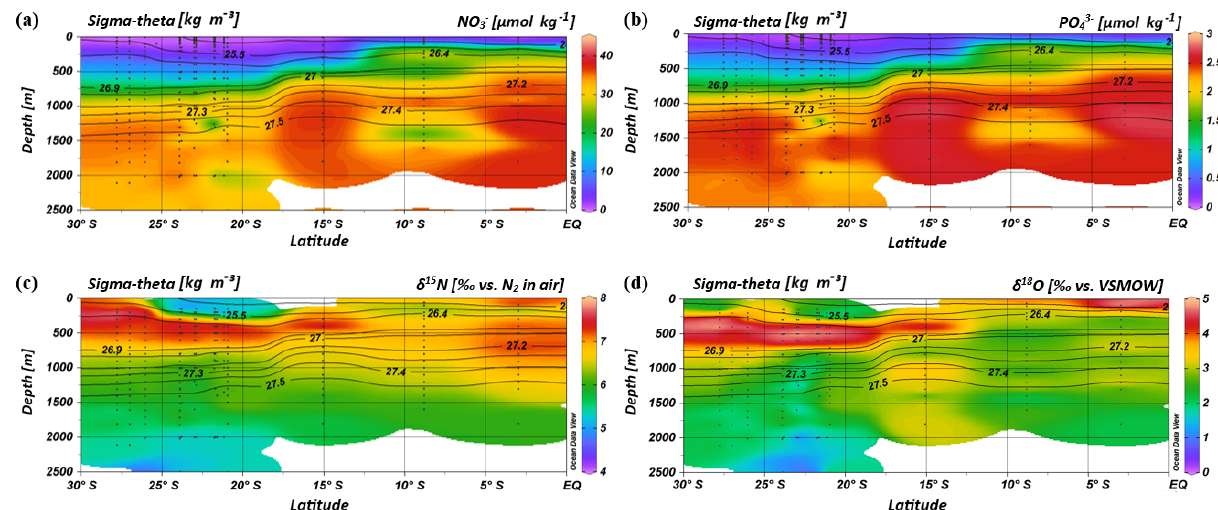
Figure 4. Profiles of nitrate (a) and phosphate concentrations (b) , and δ 15 N–NO − during the MSM 59/2 (2016) and SO 259 (2017) cruises. Contour lines indicate the potential density sigma-theta in kilograms per cubic metre (kgm − 3